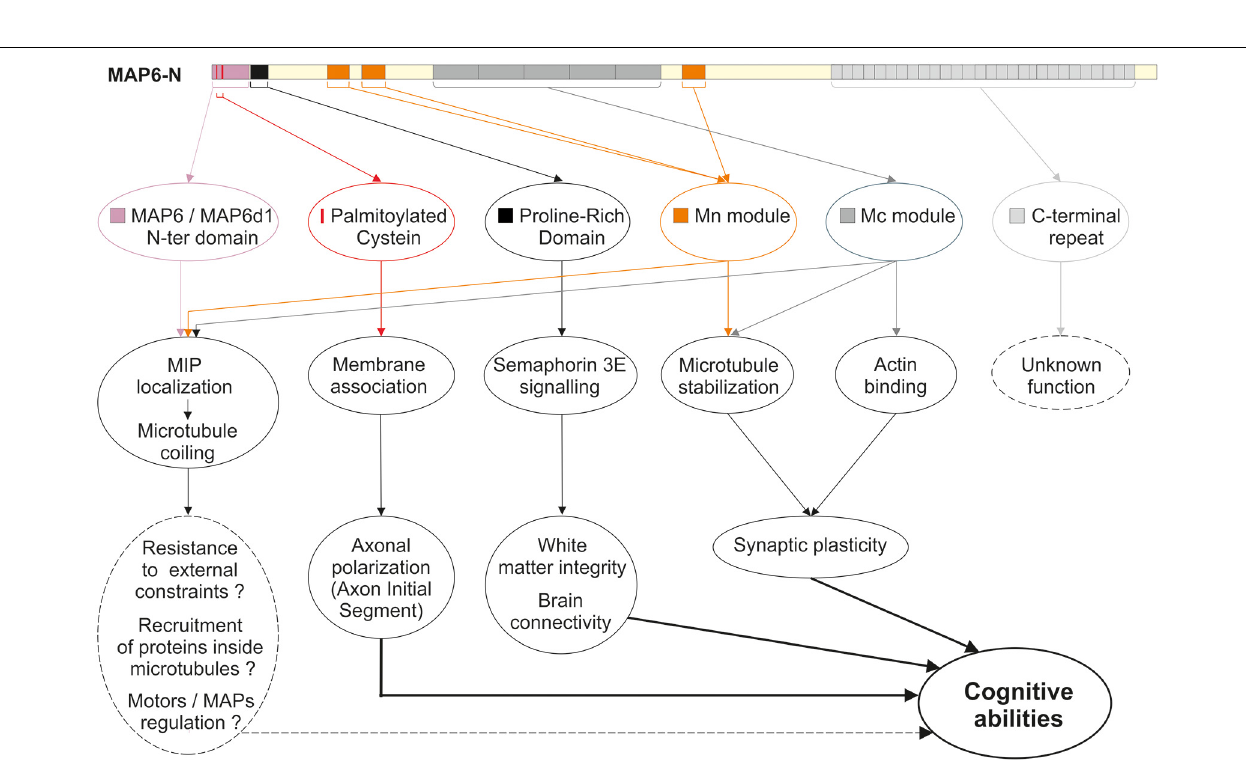
FIGURE 2 | MAP6 domains and functions. Schematic representation of MAP6, color-coded arrows indicate the different domains identified so far: the N-terminal domain shared with MAP6d1 protein (violet box); the three palmitoylation sites (red bars); the proline-rich domain involved in transduction of Semaphorin 3A signals (black box); the three microtubule-stabilizing Mn modules (orange boxes); the tandem repeats corresponding to microtubule-stabilizing Mc modules (dark gray boxes); the C-terminal repeats (light gray boxes). Below the representation, the corresponding roles of these domains are indicated, covering molecular and cellular roles, and tissues and integrated